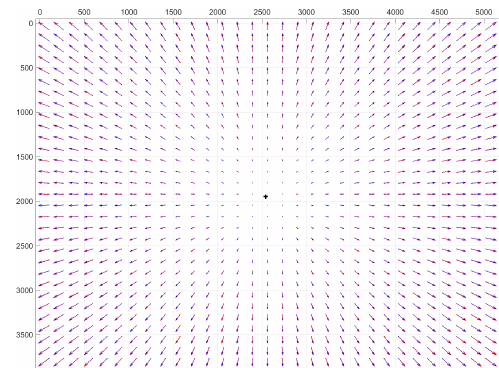
Figure 5. The homothetic error centered on PP. The direction and the magnitude of vectors represent the direction and the magnitude of added error at the origin of vectors. The cross in black indicates the position of PP.